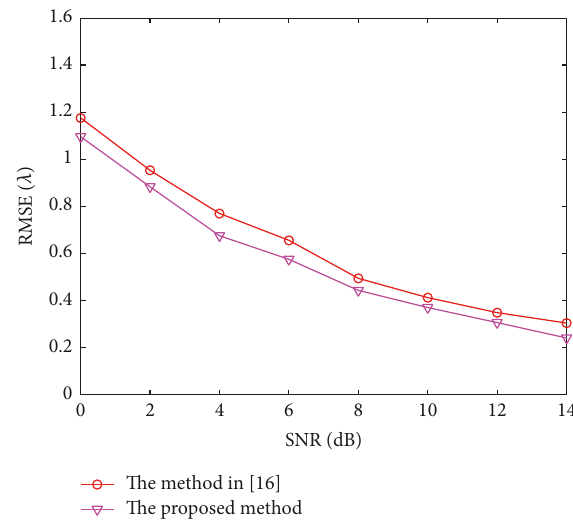
Figure 2: Angular spatial spectra for the two methods.